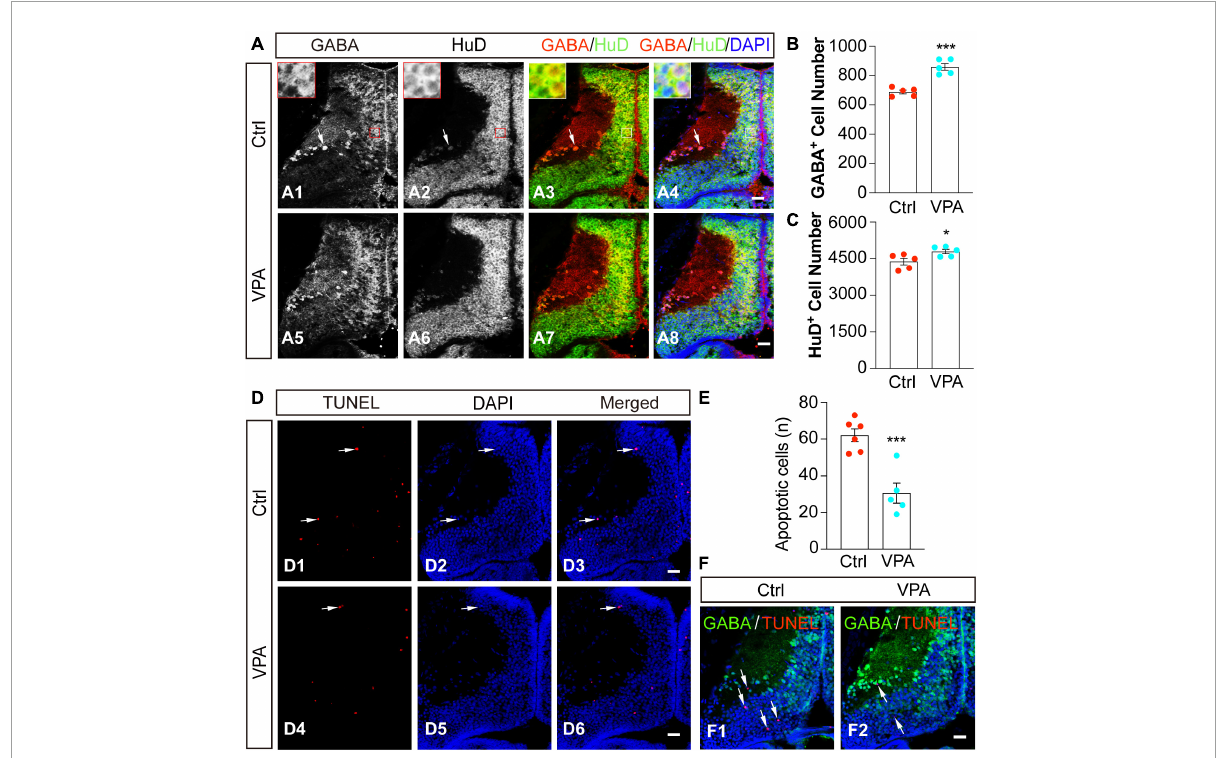
FIGURE4 Valproate acid-induced GABA + cells are HuD + differentiated neurons. (A) Control (A1–4) and VPA-reared (A5–8) optic tecta were immunostained with anti-GABA and anti-HuD antibodies at stage 48. Red/white lines indicate zoomed-in images showing that GABA and HuD are overlapped in the cell body layer. Arrows indicate that GABA + and HuD + cells are distributed in the neuropil. Scale bar = 50 µ m. (B) The data shows that the number of GABA + cells was significantly increased in VPA-raised tadpoles compared to Ctrl. (Ctrl, 688.2 ± 13.3, N = 5; VPA, 858.8 ± 22.3, N = 5; *** p < 0.001). (C) The data shows that the number of HuD + cells was significantly increased in VPA-raised tadpoles compared to Ctrl. (Ctrl, 4379.8 ± 134.8, N = 5; VPA, 4791.8 ± 89.7, N = 5; * p < 0.05). (D) Representative images of apoptosis in control